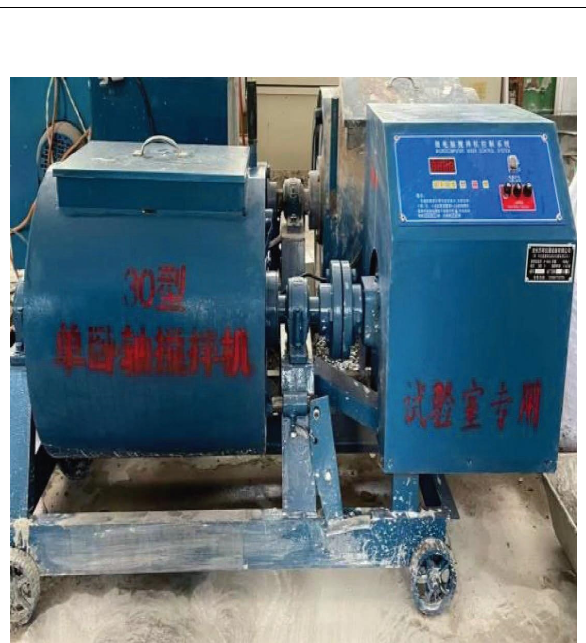
Figure 3: Concrete mixer diagram.